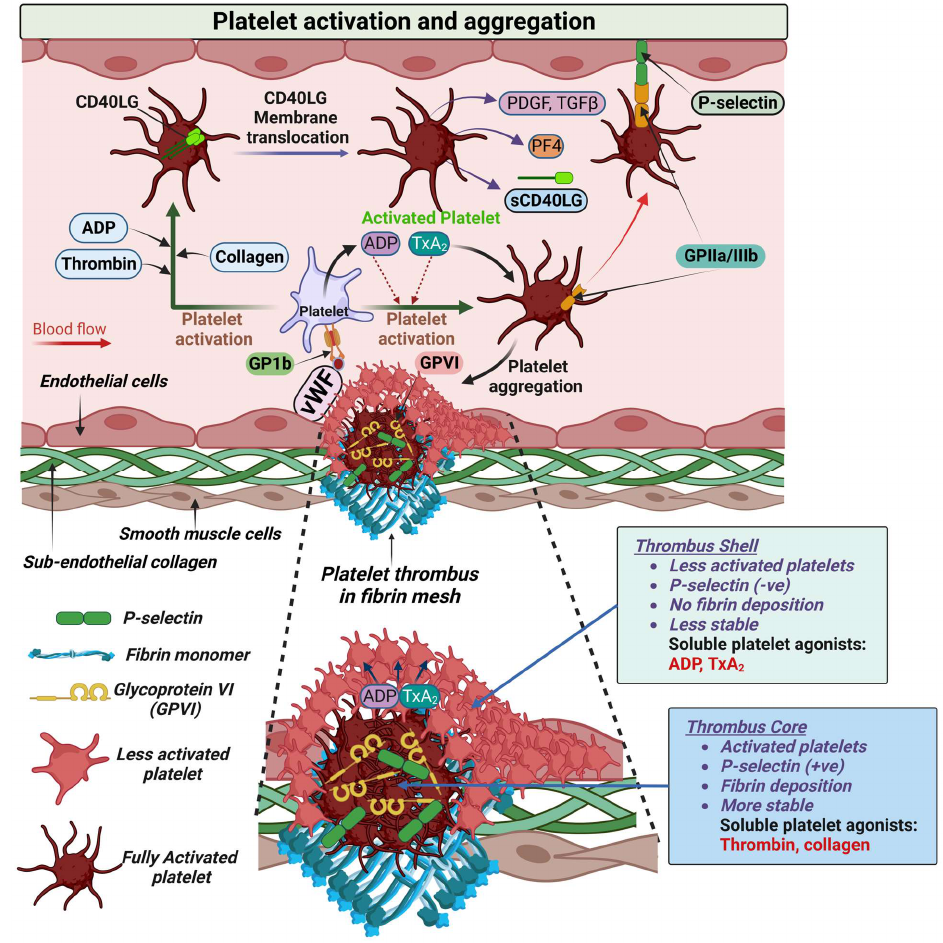
Figure 2. Platelet activation and aggregation. In response to damage to endothelial cells, circulating platelets migrate to the site of injury and bind to the Von Willebrand factor (vWF) protein, that is produced by endothelial cells through another platelet surface protein, glycoprotein Ib (GPIb), and this activates the platelets. Activated platelets release granules containing adenosine di-phosphate (ADP) and thromboxane A2 (TXA2) which bind to their respective receptors expressed on platelets, allowing more platelets to migrate and form clusters at the site of injury; this process is called “platelet aggregation”, and through this process “platelet-thrombus” is formed (in association with fibrin monomer-derived fibrin mesh and glycoprotein VI (GPVI)) at the injury site. Platelet activation also allows the membrane translocation of CD40 ligand (CD40LG). The translocation of CD40LG coincides with the release of α -granule contents, including platelet-derived growth factor (PDGF), transforming growth factor beta (TGF β ), and platelet factor 4 (PF4). The surface-expressed CD40LG is cleaved and shed from the platelet surface in a time-dependent manner as sCD40LG. At the site of injury, platelet–endothelial interaction yields a gradient of platelet thrombus with a core (thrombus core expressing P-selectin) of fully activated platelets overlaid by a shell (thrombus shell) of less activated platelets. Activated platelets release soluble mediators like ADP and TxA2 which act as a positive-feedback mediator of platelet adhesion by increasing the expression of integrin GPIIb/IIIa- receptor and ensuring the rapid activation and recruitment of platelets into the growing thrombus. Inset (between dotted lines), a high-power illustration of ruptured endothelium and the components of platelet thrombus (thrombus core and thrombus